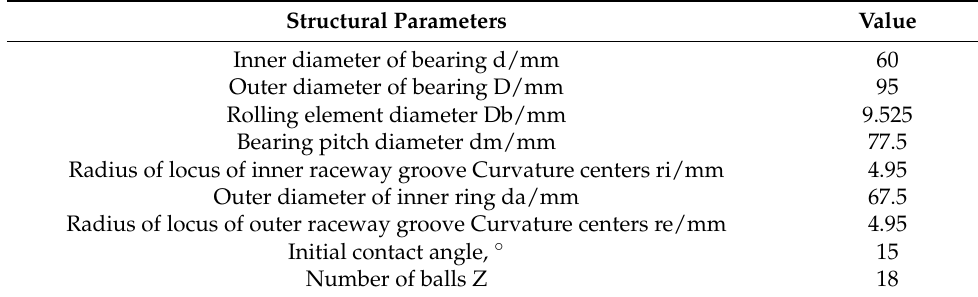
Table 3. Structural parameters of angular contact ball bearing